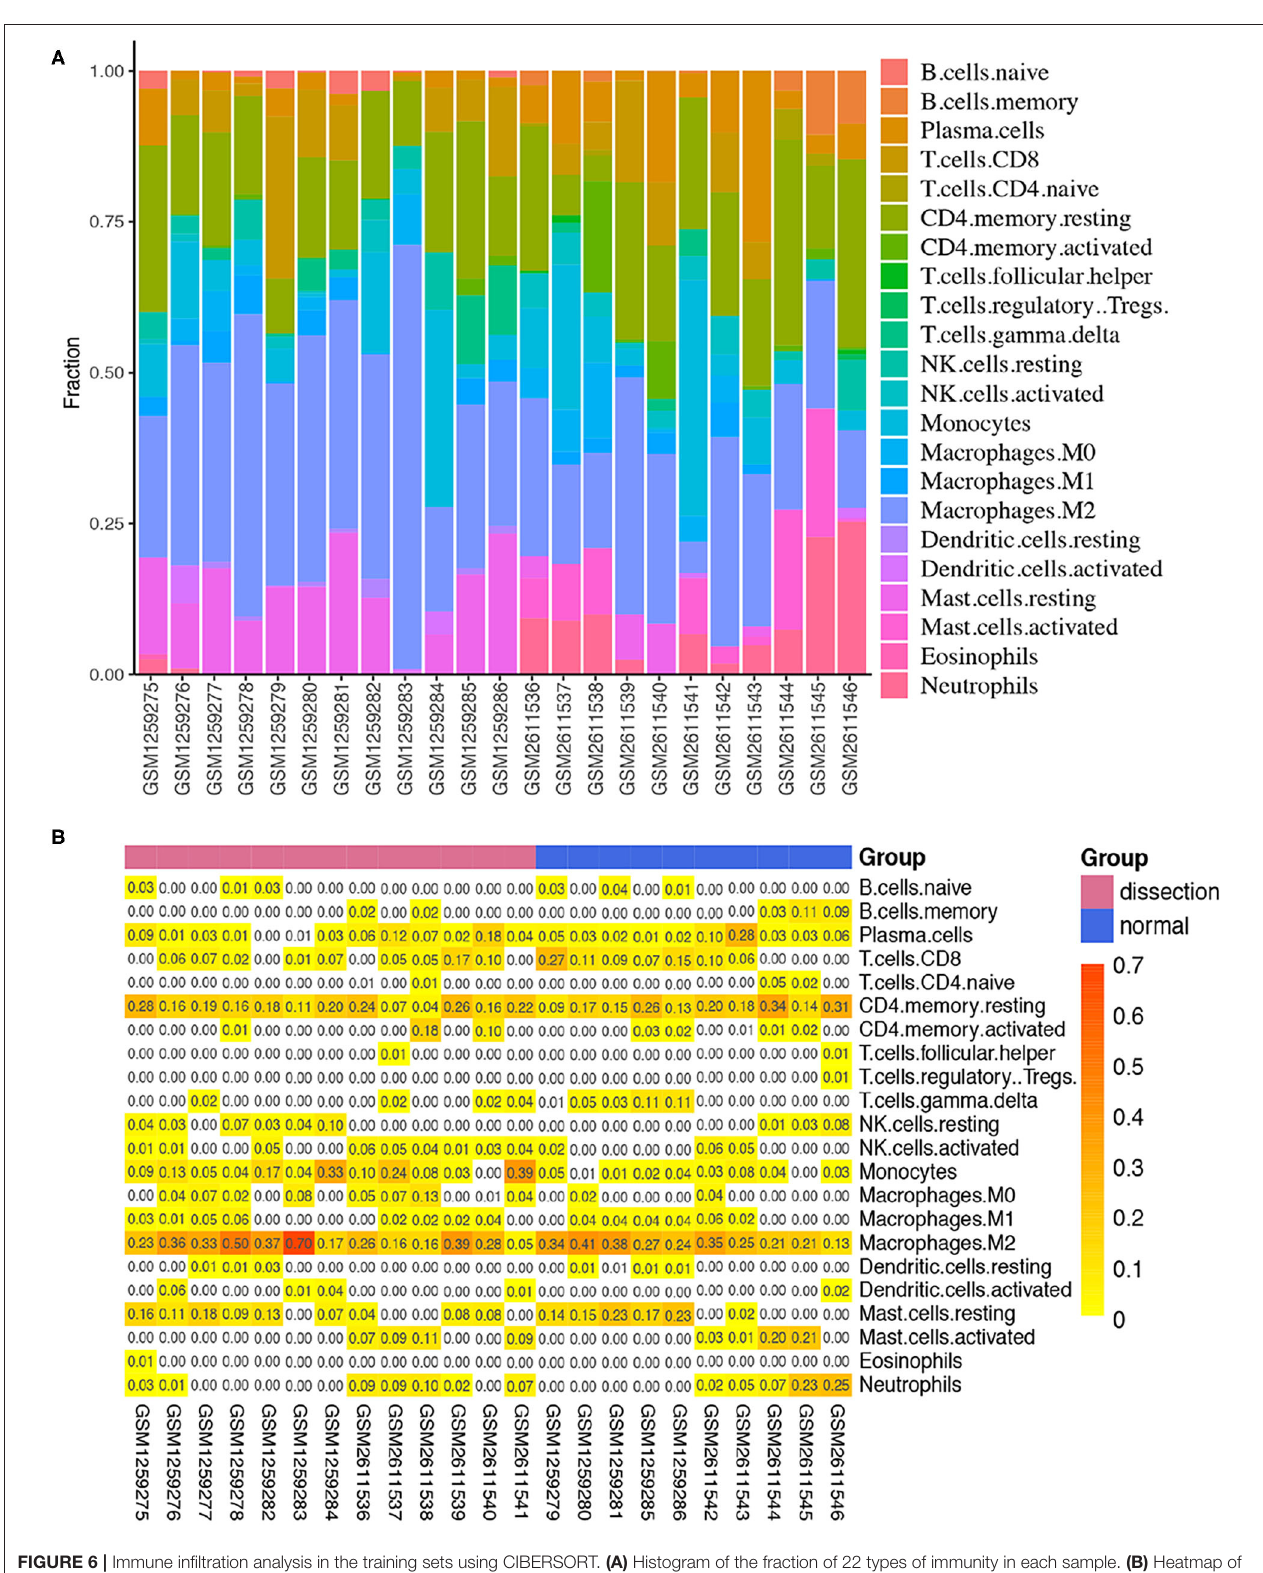
Frontiers in Cardiovascular Medicine |